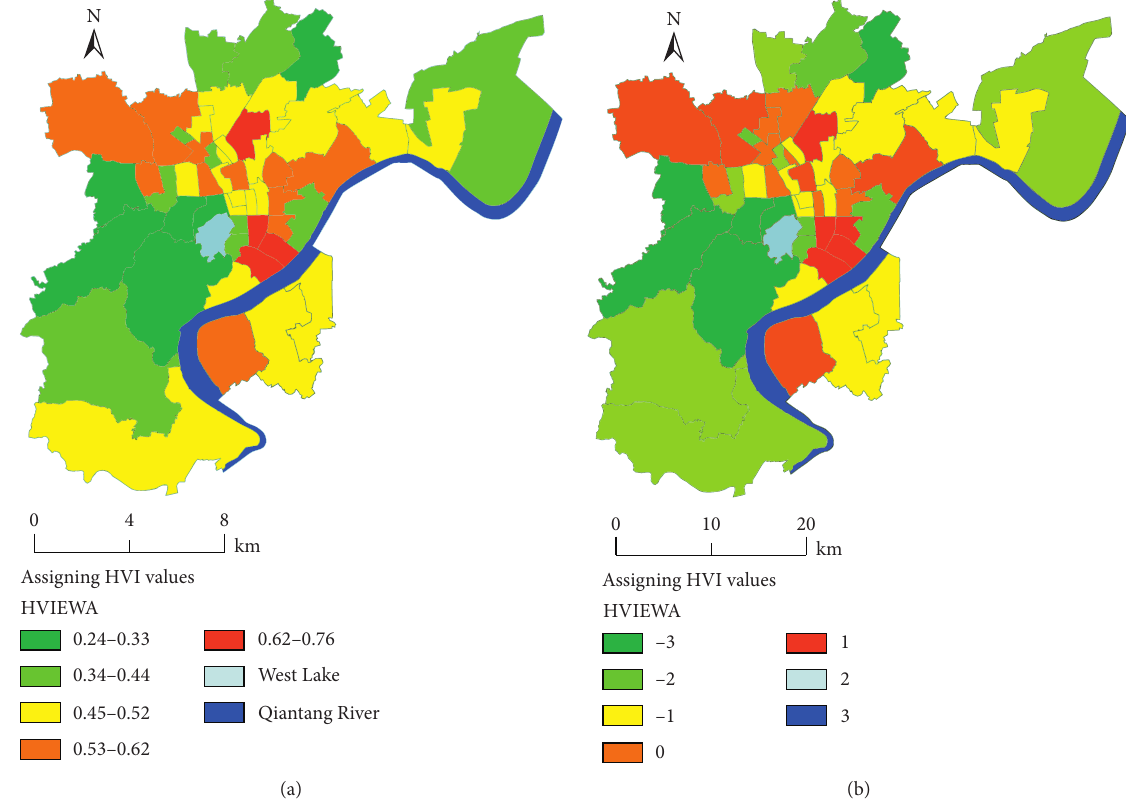
Figure 4: (a) The spatial distribution of HVI in Hangzhou using EWA at the pixel level; (b) the spatial distribution of HVI after assigning HVI